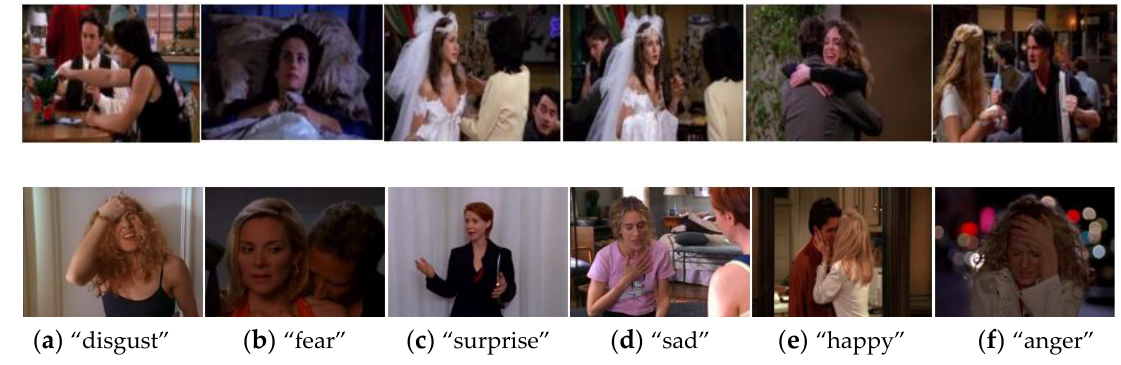
Figure 5. Sample frames of the CAER-S dataset.